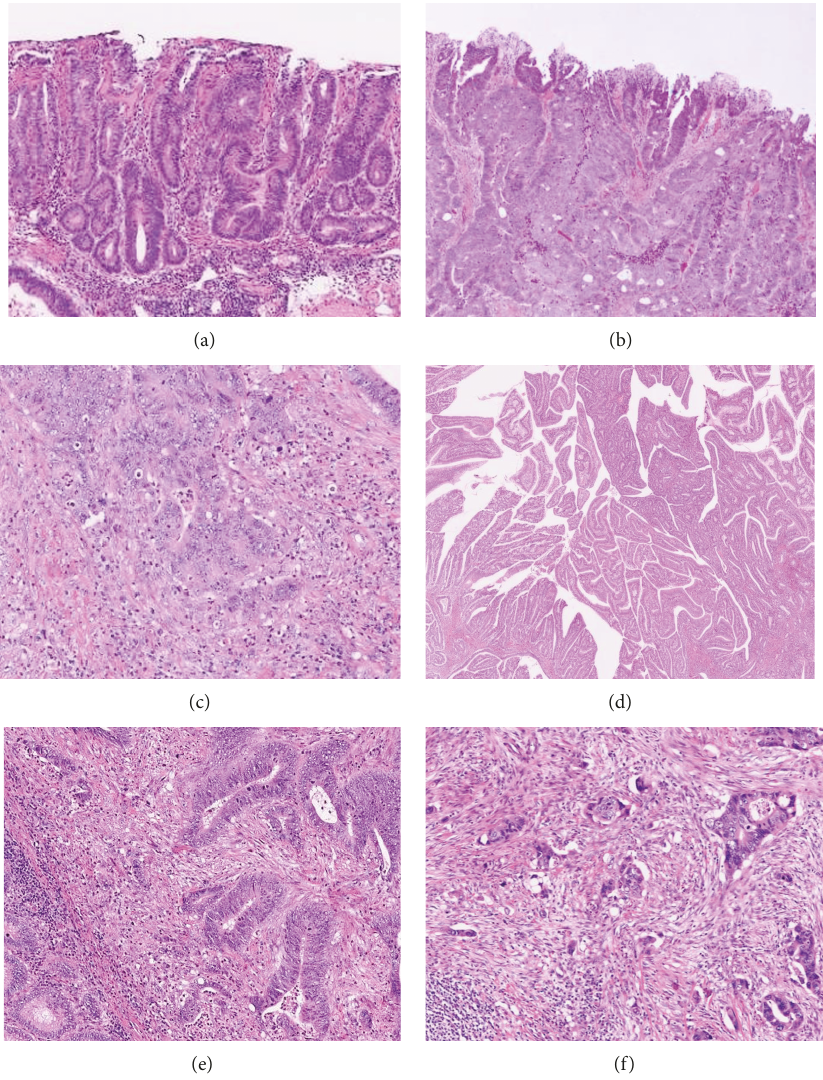
Figure 2: Well-di ff erentiated adenocarcinoma and various other histological fi ndings. (a) Well-di ff erentiated tubular adenocarcinoma. (b) Moderately di ff erentiated tubular adenocarcinoma. (c) Poorly di ff erentiated adenocarcinoma. (d) Papillary di ff erentiated adenocarcinoma. (e) Poor di ff erentiated nest. (f)